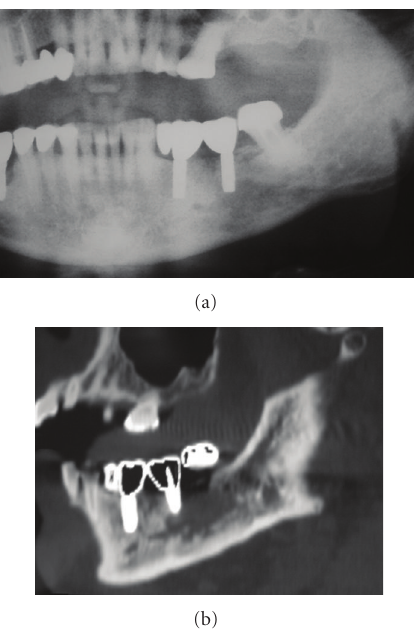
Figure 4: (a) A panoramic radiography showing only low-di ff usion radiolucency around the left implant. (b) Computerized tomog- raphy image revealing necrotic bone involving left mandibular implant (September